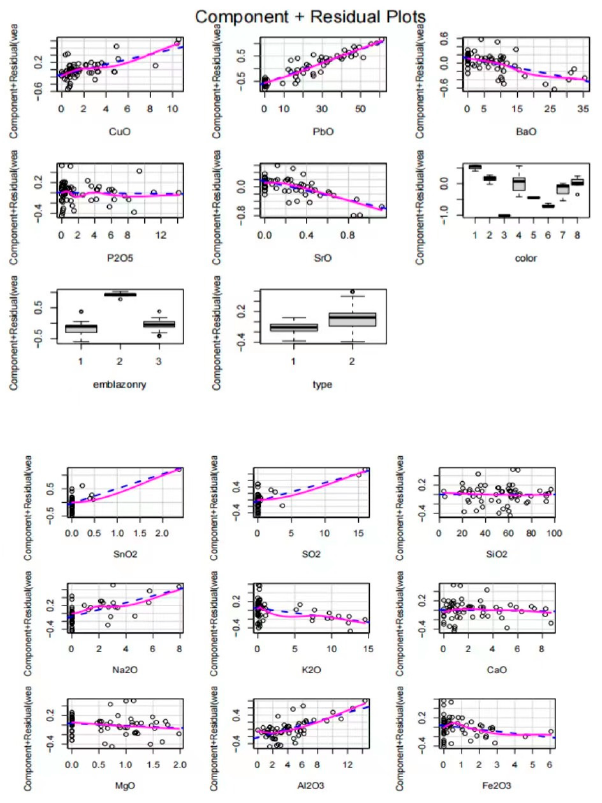
Figure 3. Linear regression result.